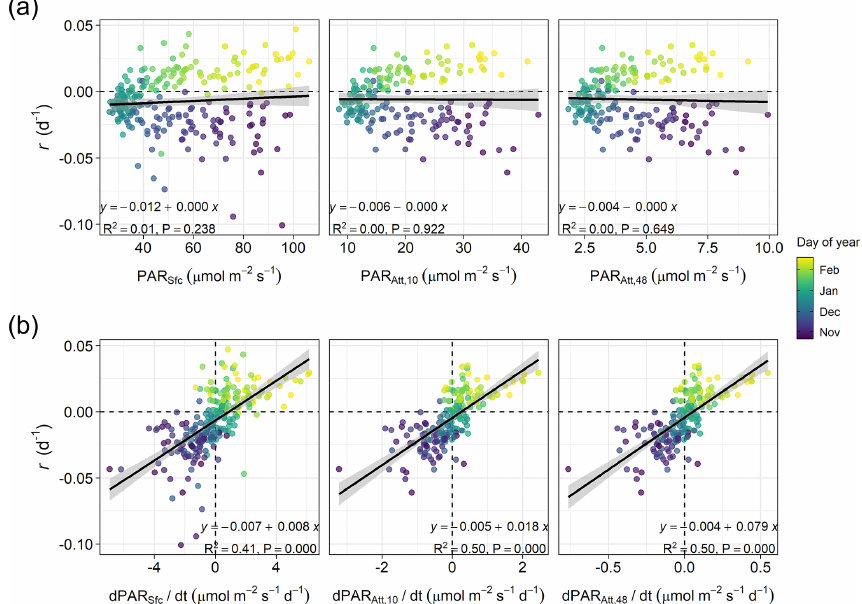
Figure 4. Linear relationships in winter (60d before and after the winter solstice) between (a) phytoplankton biomass accumulation rate ( r ) and average photosynthetic active radiation (PAR) at the sea surface (PAR Sfc ), for the 0–10m layer (the layer where phytoplankton was sampled, PAR Att , 10 ), or for the entire water column (i.e., 0–48m depth, PAR Att , 48 ), or between (b) r and average rates of change in PAR (dPAR Sfc / d t , dPAR Att , 10 / d t , and dPAR Att , 48 / d t ). The shaded area represents the 95% confidence interval associated with the estimated linear correlation (black line). The equation, proportion of variance explained ( R 2 ), and p -value ( P ) of the relationships are shown. Horizontal and vertical dashed lines indicate zero